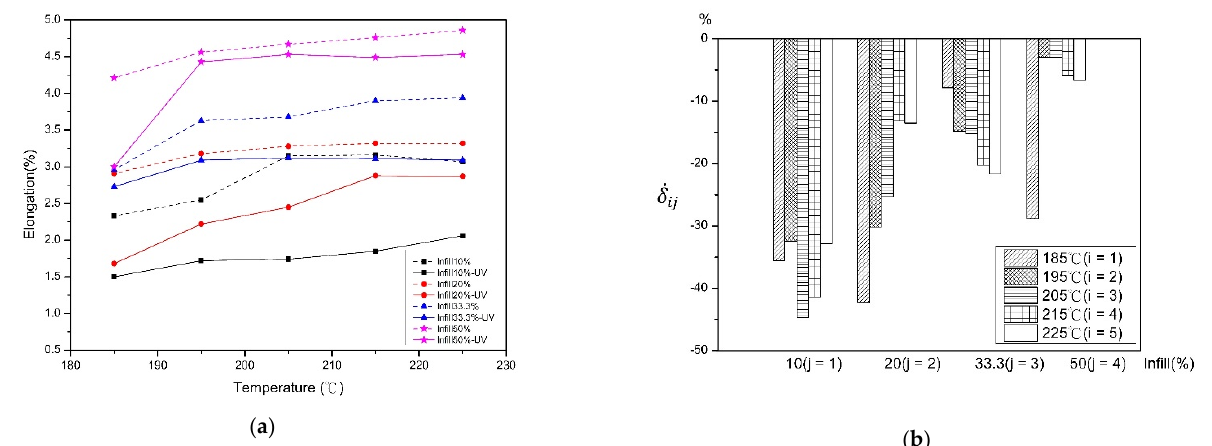
Figure 5. Before and after UV curing ( a ) elongation and ( b ) the rate of change.